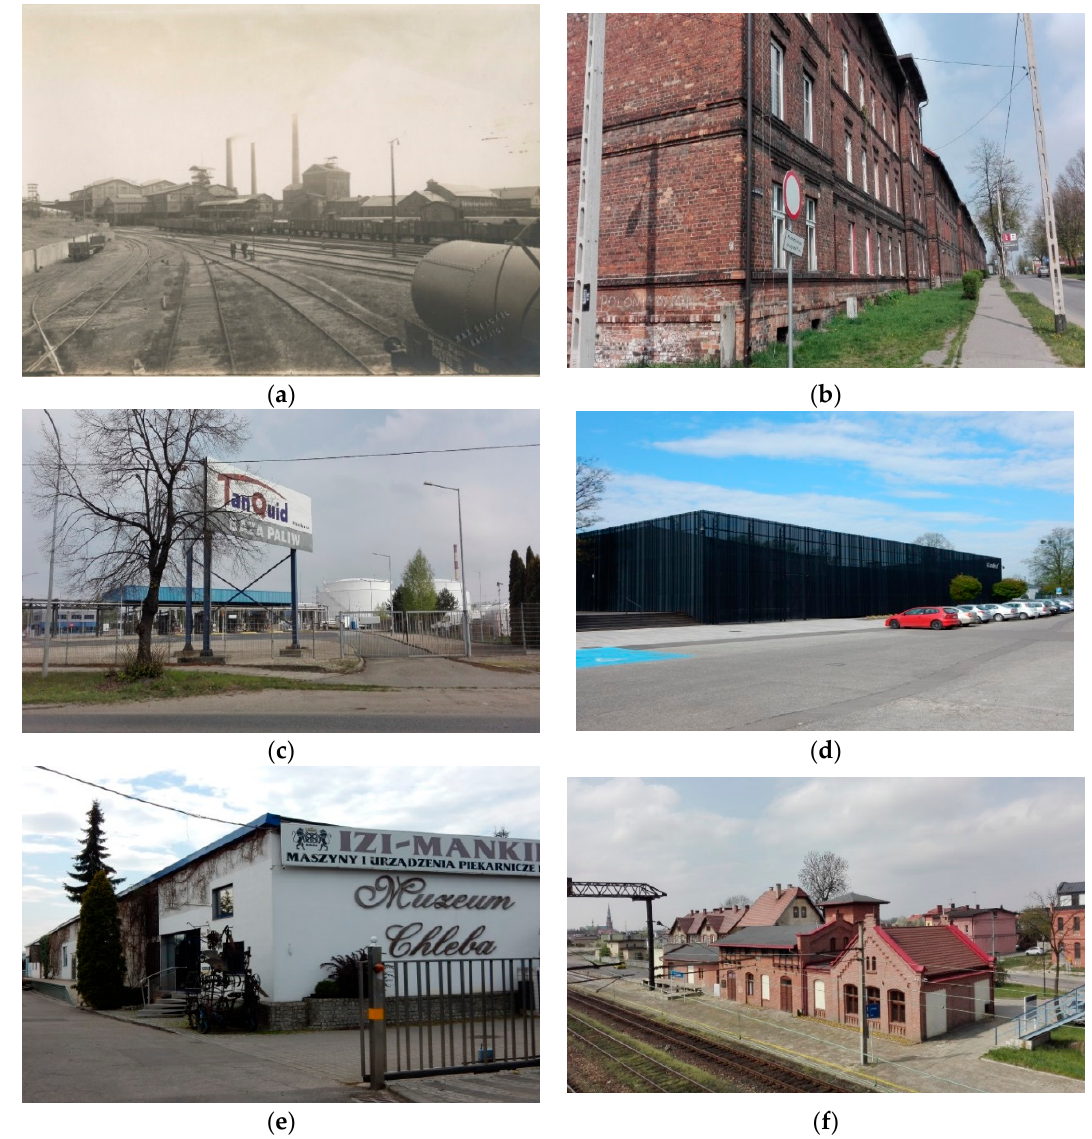
Figure 5. Radzionków ( a ) old photograph of the coal mine in Radzionków by Max Steckel; ( b ) mining estate in a town without a mine; ( c ) fuel base; ( d ) Kanlux Technology and Exhibition Centre; ( e ) Museum of Bread, School, and Trivia; and ( f ) Centre for Documentation of Upper Silesians’ Deportation to the Soviet Union in 1945 located in the former railway station building (a: Max Steckel: from the collection of the Radzionków Town Hall, ( b )–( f ) illustration sourced by authors).